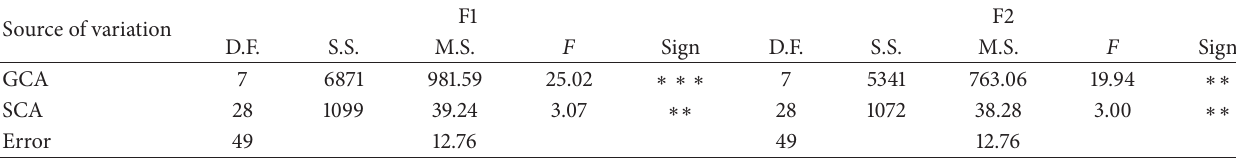
Table 10: Analysis of estimates of combining ability at adult stage.